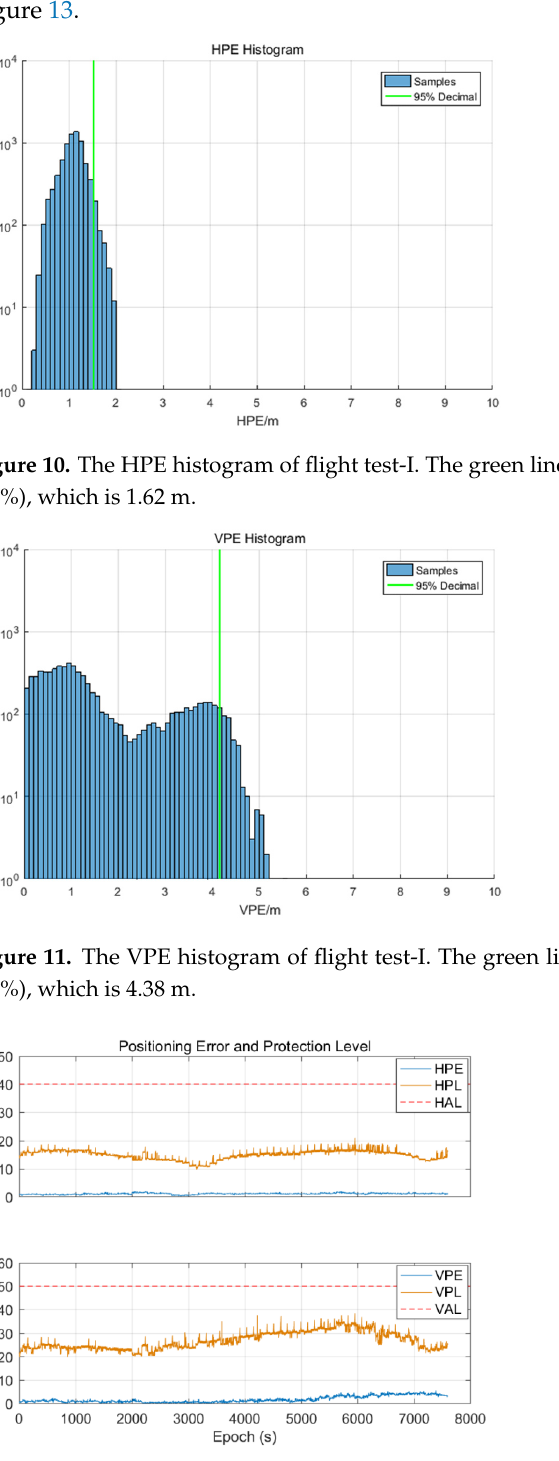
Figure 9. Flight trajectory of test-I. The green line is the trajectory, while the flight distance and azimuth are marked by the red line and the yellow text.